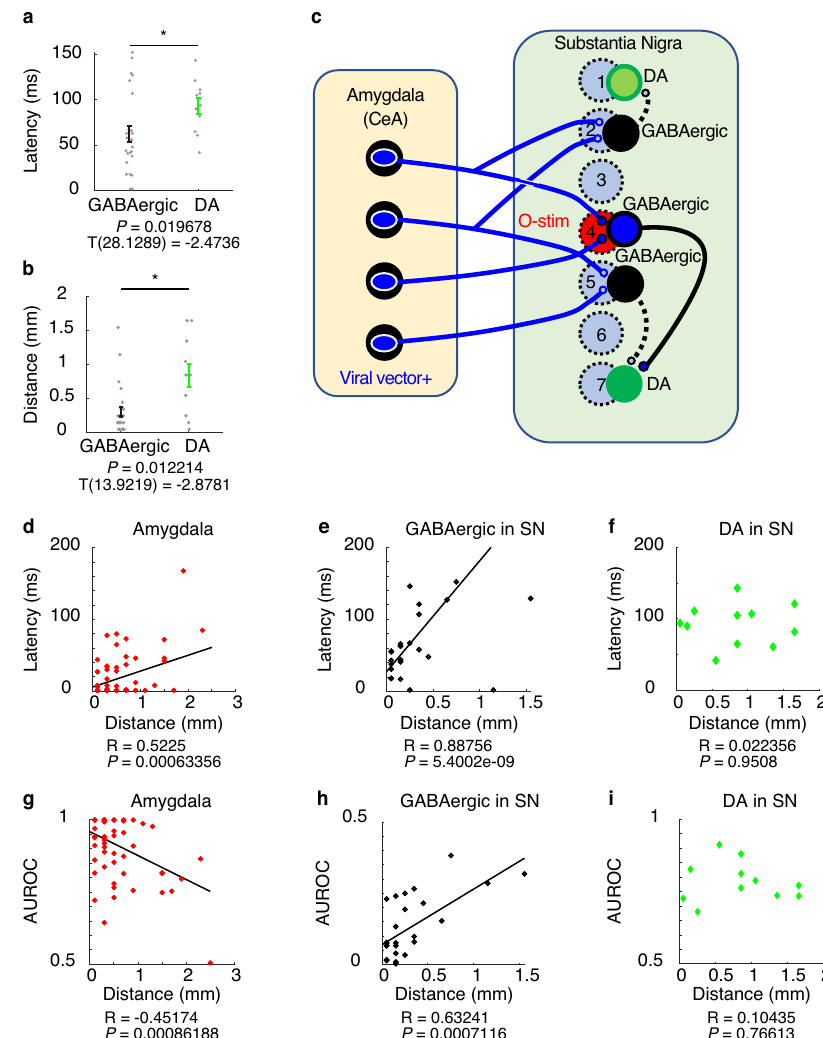
Fig. 4 | Amygdala-GABAergic neuron in SN-DA neuron circuit and environ- mental information. a Averaged latency for the neuronal modulation started by optogeneticstimulation.Errorbarsshow±1SEM,andeachgraydotrepresentsone neuron. Responses are inhibited for putative GABAergic neurons ( n =25) and excited for putative DA neurons ( n =11). b Distance between effective optical sti- mulationandrecordingsitesforputativeGABAergicneurons,( n =25)andputative DA neurons ( n =11). Error bars show ±1 SEM, and each gray dot represents one neuron. A two-sided paired t -test was applied for statistical testing ( a , b ).